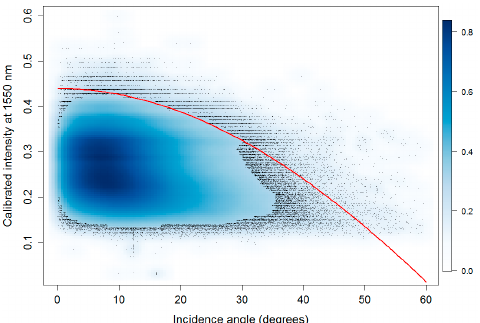
Figure 5. An example of a density scatterplot of laser returns used to estimate the model parameters for maple ( n = 684,617). The density values represent a 2D kernel density estimate. Two percent of the points with the lowest kernel density were plotted (black dots). The red line represents the fitted model for incidence angle correction.